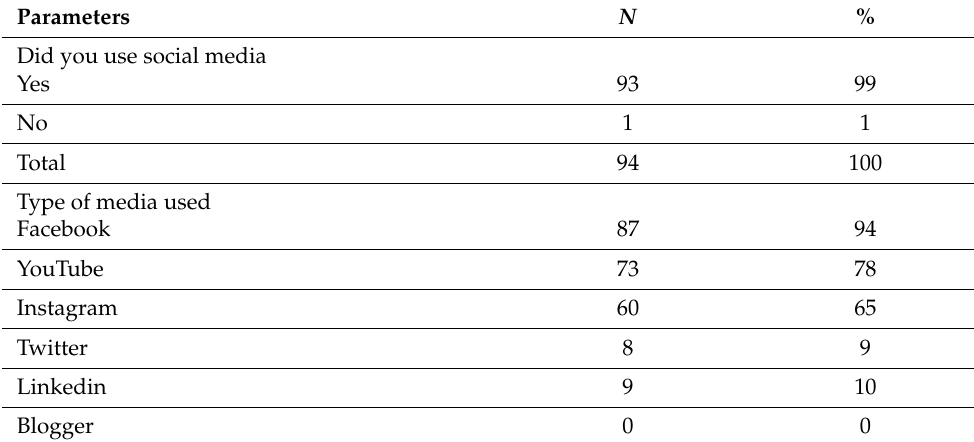
Table 1. Frequency distributions and percentages of the participant’s responses regarding the use and the type of social